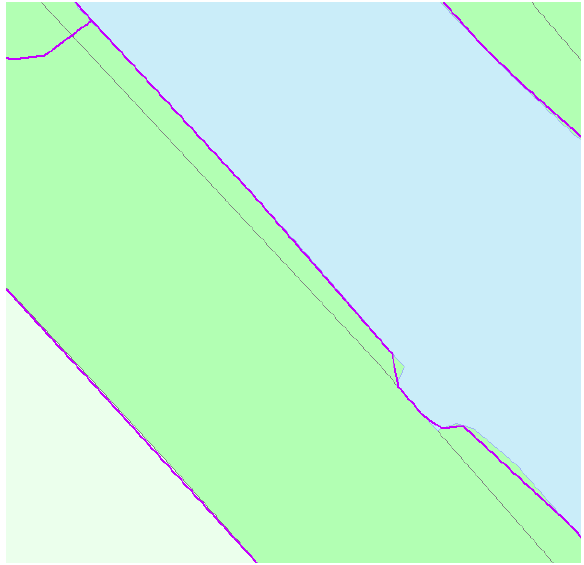
Figure 9. Adjustment result of Weser riverbank (test case 1) However, all the nodes of ATKIS align to the correct corresponding line features in ALKIS. Table 3 gives a brief overview of the adjustment results. As the mean link length and the mean shift are both the same order in the last iteration and below 10 cm, we can assume to have a convergent solution.